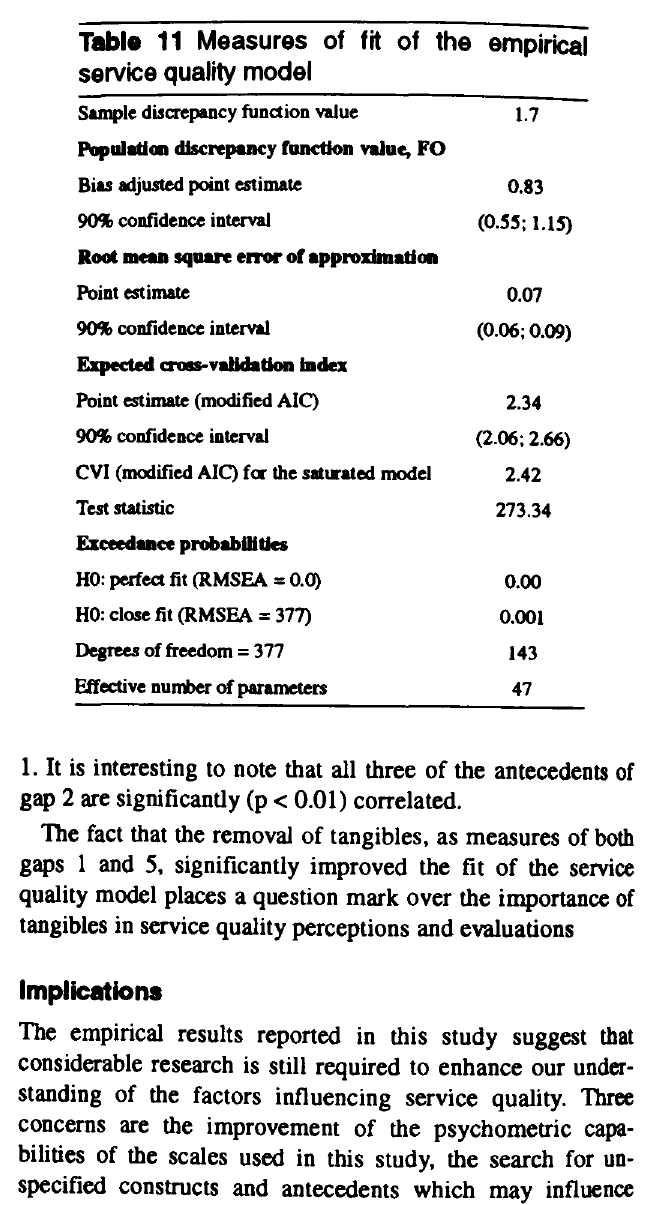
Table 1 O Measures of fit of the amended Table 11 Measures of fit of the